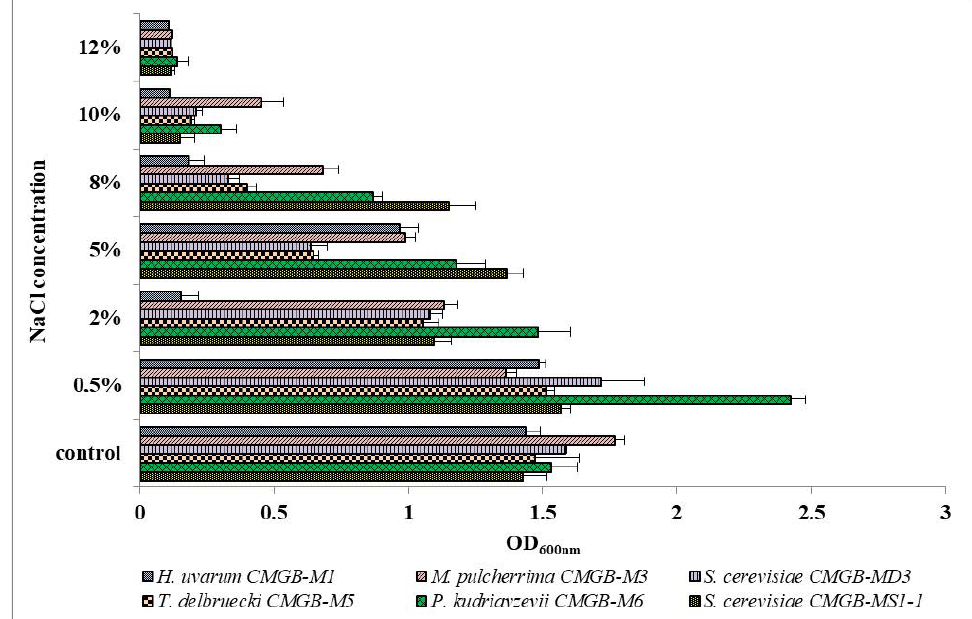
Figure 6. Growth rate of yeasts isolated from wort sediment after 24 h of cultivation in the presence of osmotic stress induced by NaCl at different